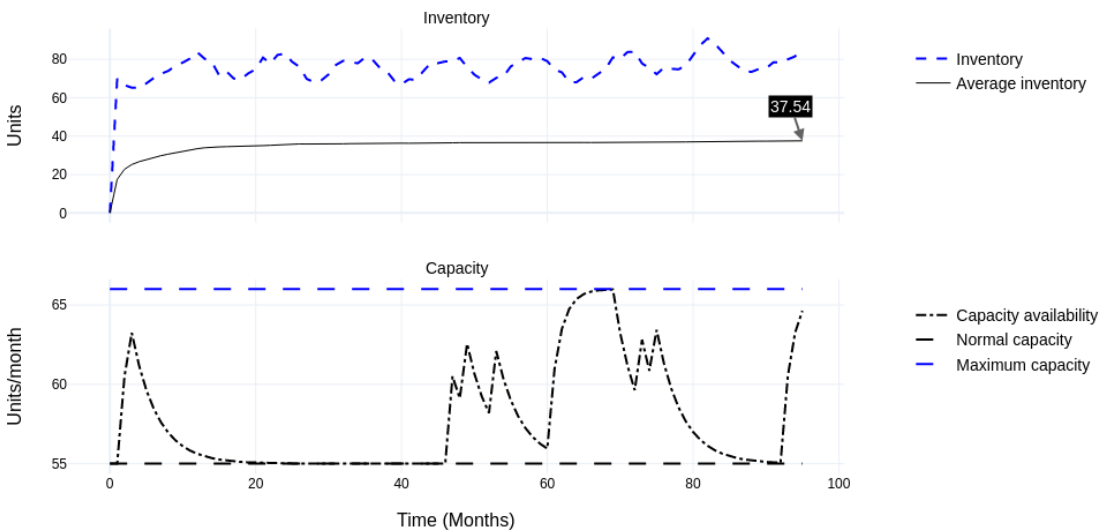
Figure 14. Whole-model simulation results: RNN with discretionary capacity; quick ramp-up and slow ramp-down.